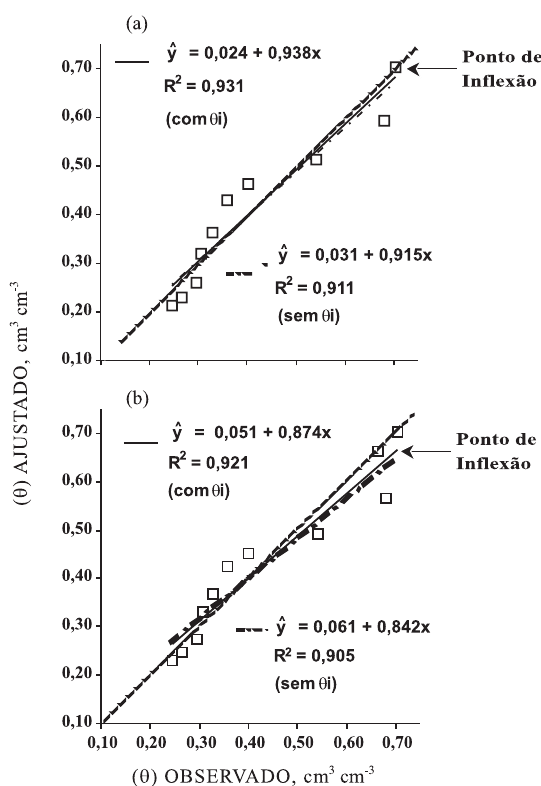
Figura 2. Linha 1:1 tracejada, dados observados e ajustados de teor de água ( θθθθθ ) das curvas de retenção de água no solo pelo método da centrífuga considerando as equações propostas por (a) van Genuchten e (b) Hutson & Cass.